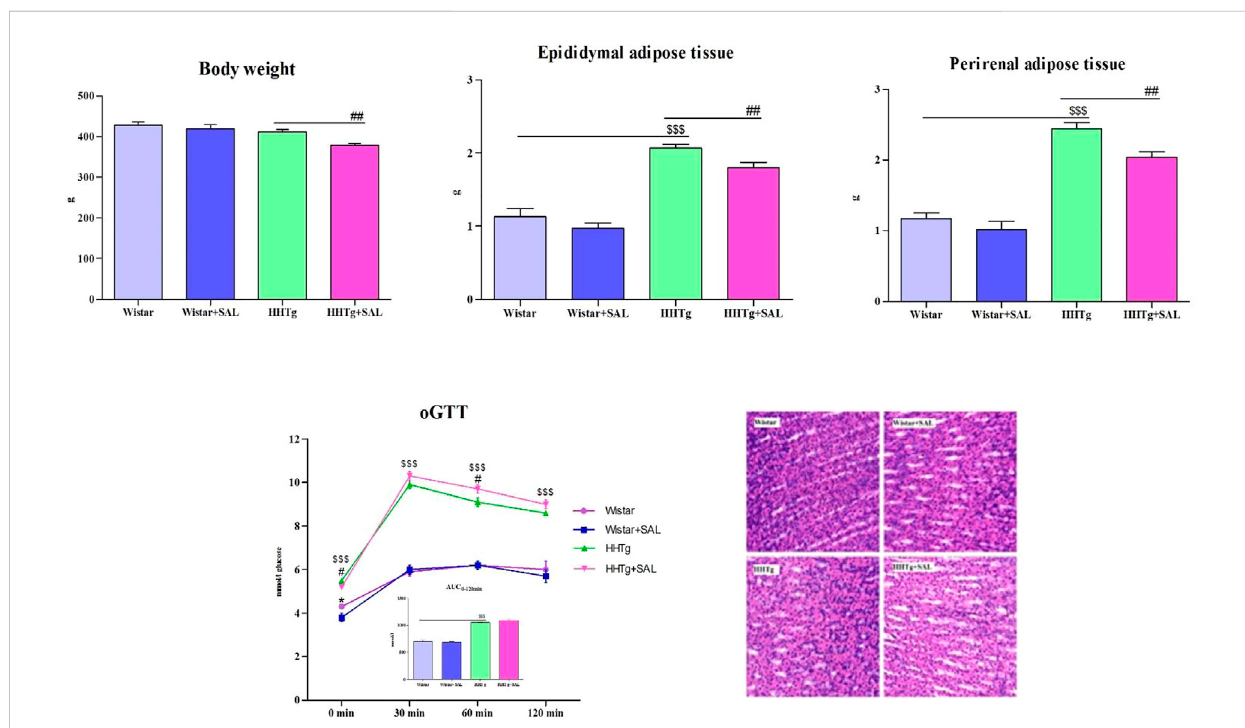
FIGURE 1 Effect of salsalate treatment on body weight and relative weight of visceral adipose tissues — epididymal and perirenal, and oral glucose tolerance test in Wistar control and hereditary hypertriglyceridemic (HHTg) rats. Values are expressed as mean ± SEM; n = 8; Effect of salsalate on histological evaluation of the stomach wall. Representative histological images of intact gastric mucosa of each group showing neither in fl ammatory changes nor bleeding (hematoxylin and eosin (H&E) staining, 400×). * denotes signi fi cance re fl ecting the effect of Wistar vs. Wistar + SAL, # denotes signi fi cance re fl ecting the effect of HHTg vs. HHTg + SAL, $ denotes signi fi cance re fl ecting the effect of Wistar vs. HHTg; * p ˂ 0.05; # p ˂ 0.05; $$$ p ˂